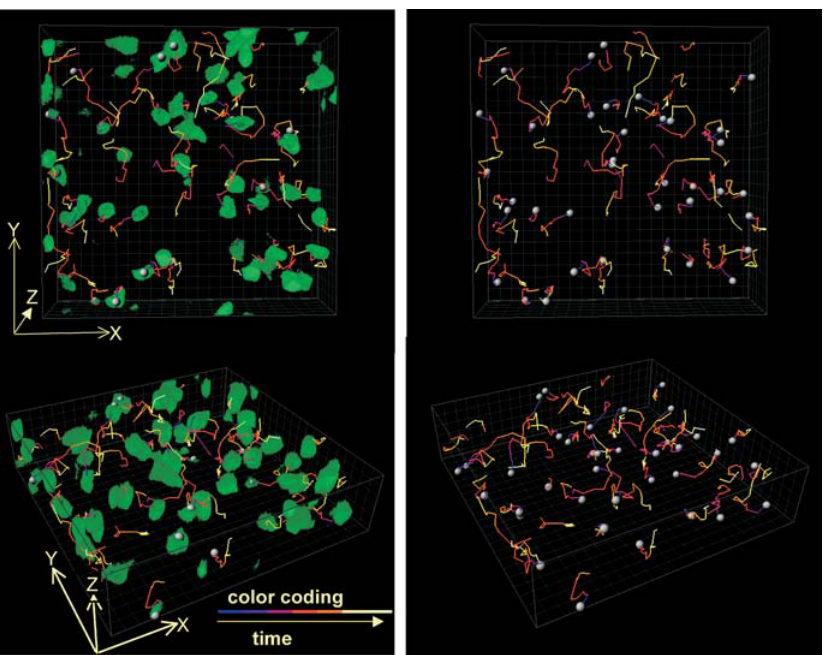
Figure 1. Tracking Thymocyte Migration in 3D Tracking software identifies the positions of individual thymocytes over time. Trajectories of individual cells are shown as tracks, which are color coded to indicate increasing time from blue (start of imaging) to yellow (end of imaging) (see Videos S1–S4). Left panels show fluorescent signal from thymocytes at a single time point superimposed on cell tracks. Right panels show the positions of thymocytes (indicated by spheres) at a single time point. Top panels show a projection in which the z -axis is perpendicular to the viewer. In the bottom panels the image is rotated to display the z dimension. DOI: